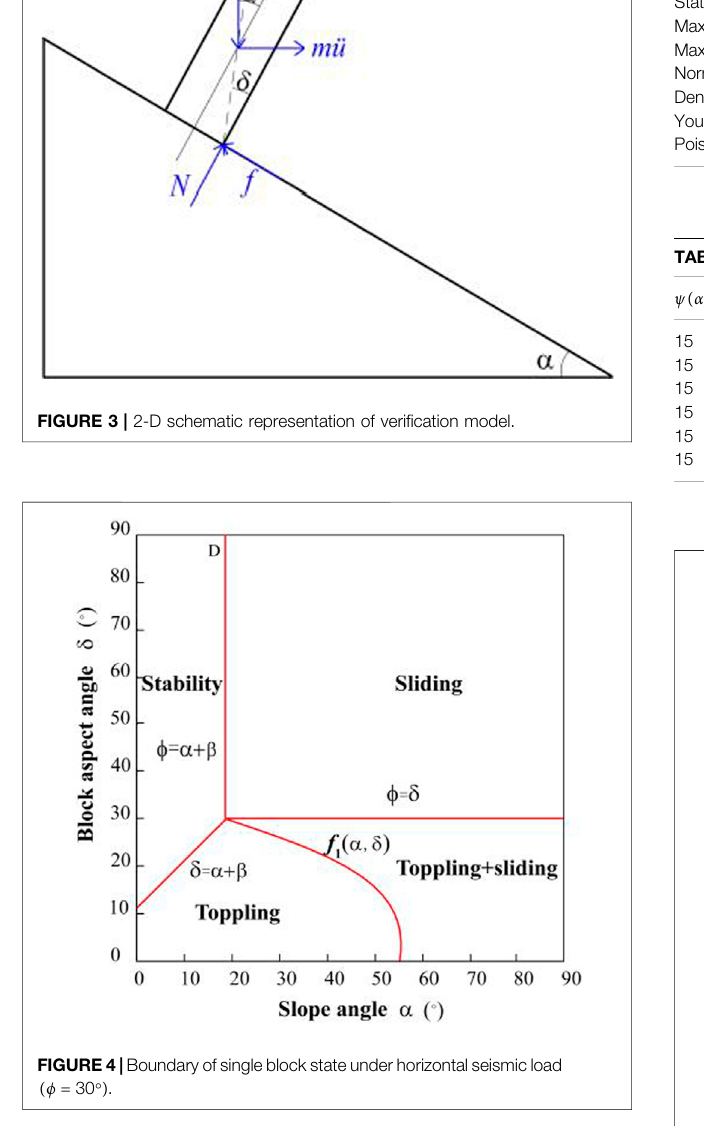
FIGURE 5 | Comparison of instability modes of a single block ( ϕ (cid:1) 30 ° , β (cid:1) 0 .